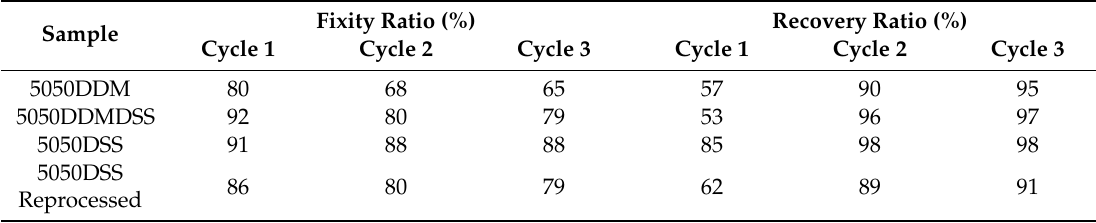
Table 2. Fixity and recovery ratios of different samples cured with DDM/DSS tested by DMA.